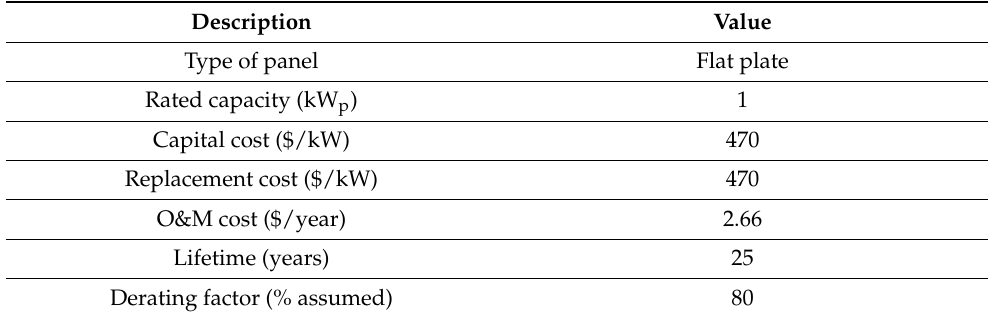
Table 2. Technical specifications of the PV